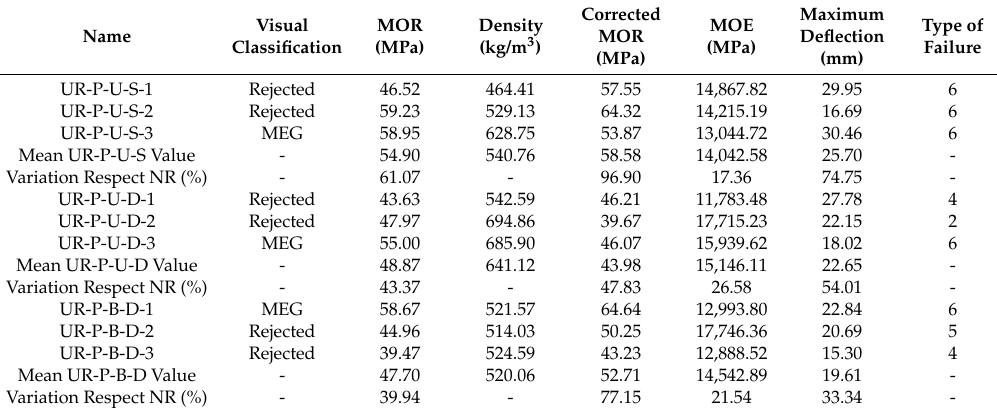
Table 6. Mechanical results obtained from bending tests for UR-P-U-S, UR-P-U-D and UR-P-B-D beams. Visual classification, MOR, density, density-corrected MOR, MOE, maximum deflection and type of failure. CFRP suppliers: SIKA ® and DRIZORO ® .